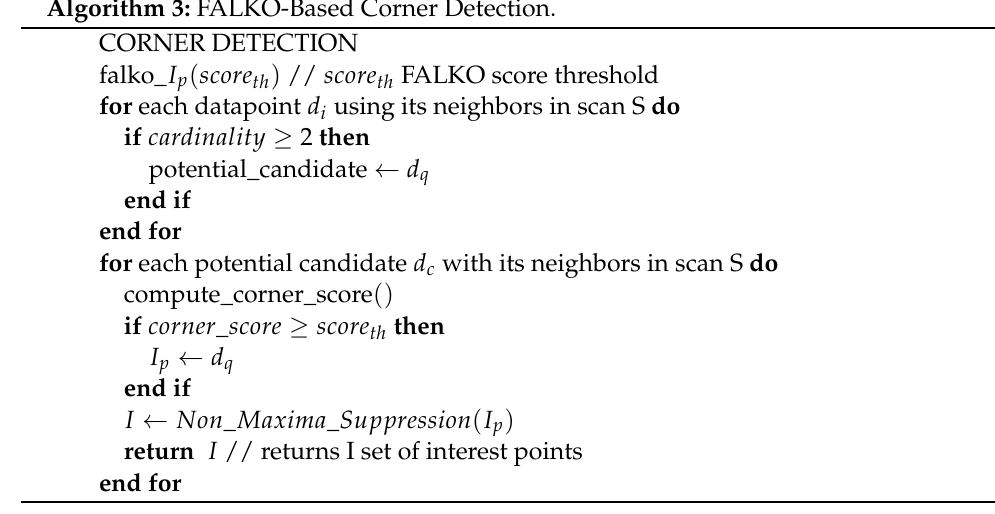
Algorithm 3: FALKO-Based Corner